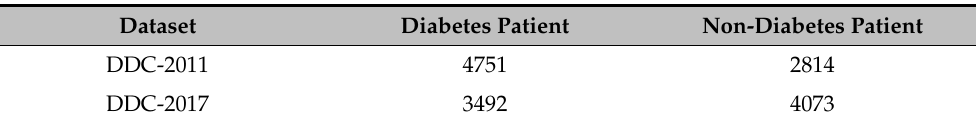
Table 2. Class label description and class-wise sample distributions of the proposed DDC-2011 and DDC-2017